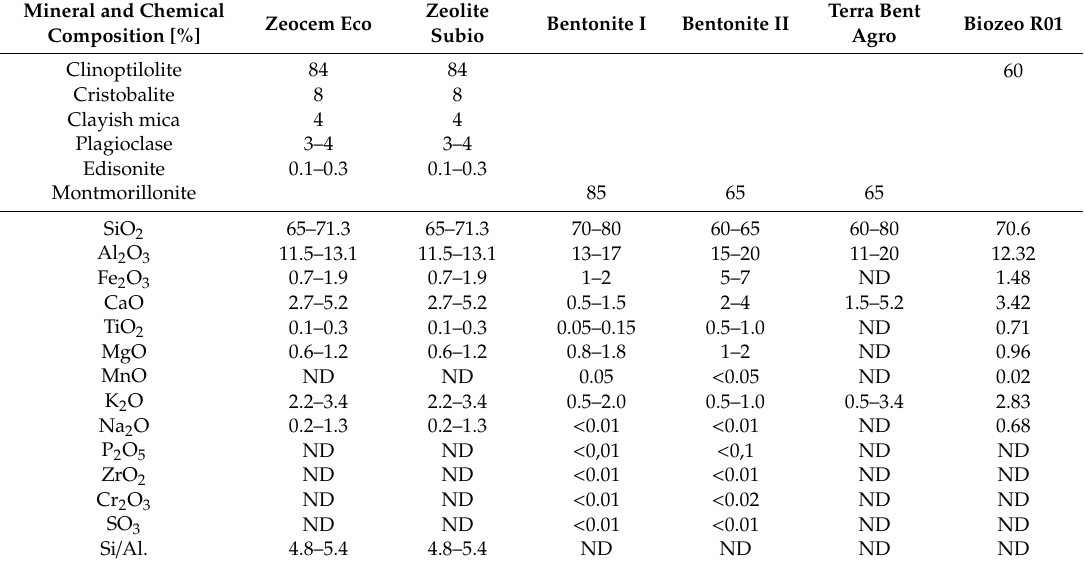
Table 4. The mineral and chemical composition of used